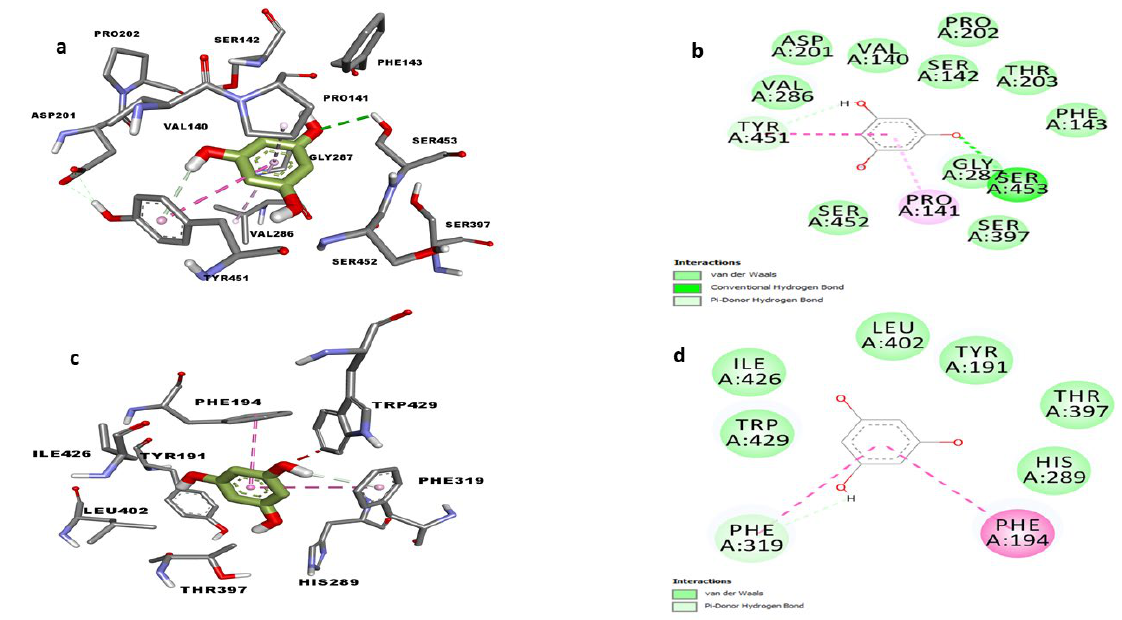
Figure 10. 3D and 2D molecular interactions of phloroglucinol with trypanosomal sialidase ( a ) and ( b ) and PLA 2 ( c ) and ( d ) after 50 ns molecular dynamics simulation studies.